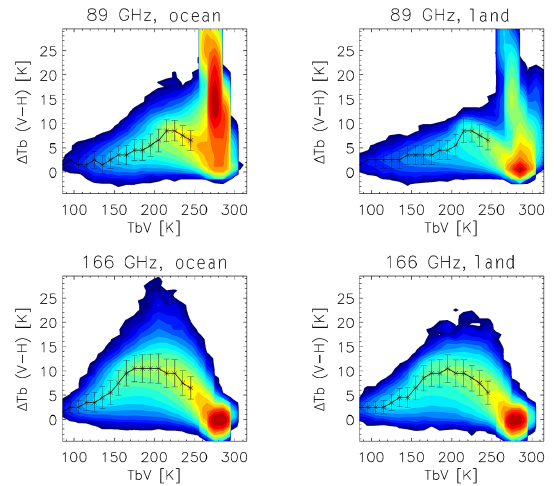
Figure 3. Joint PDFs of (cid:49) TB–TB V statistics for the [0, 10 ◦ ]N lat- itude bin. The GMI 89GHz (top) and 166GHz (bottom) data in July 2014–2015 are used in the analysis, but separately for ocean (left) and land (right). Clear-sky data are excluded in computing the PDF peaks, while the cloudy-sky PDF peaks are connected by a black line with the standard deviation of PD shown for each bin. Cloudy sky is determined by the 3 σ threshold method using the 183 ± 3GHz radiances. The color contour for the PDFs is in log